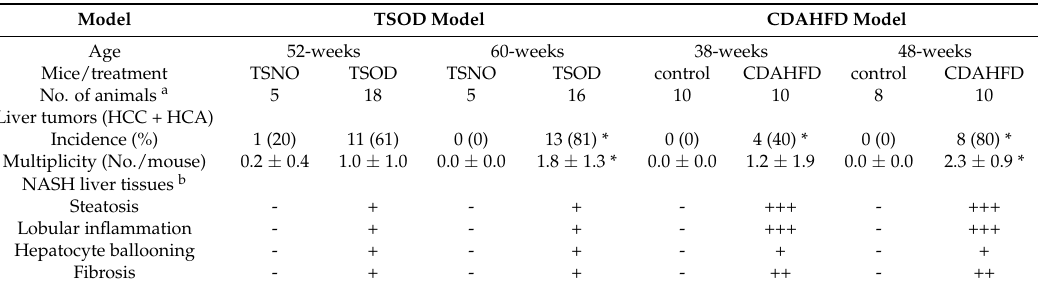
Table 2. Histological findings in mouse